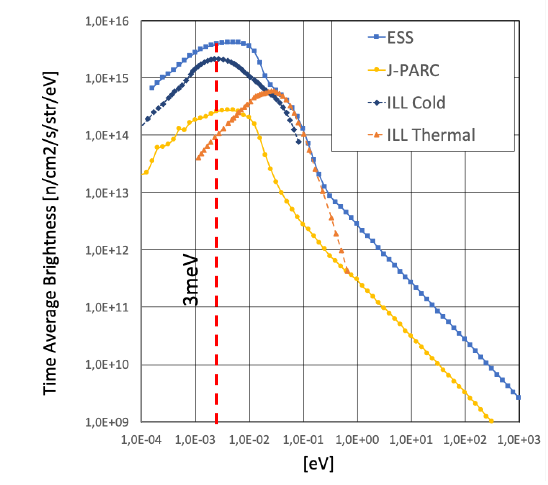
Fig. 1 . Time averaged brightness of ESS (5 MW), ILL (57 MW) and J-PARC's coupled moderator (1 MW) [2]. In the report we will discuss for Ei = 3meV as Typical